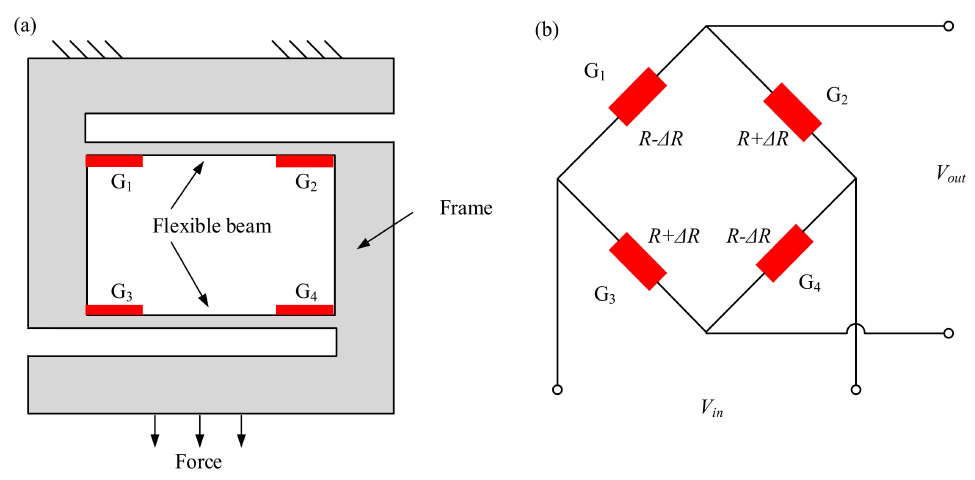
Figure 6. Principle of the force sensor: ( a ) schematic diagram of the structure; ( b ) Wheatstone bridge.